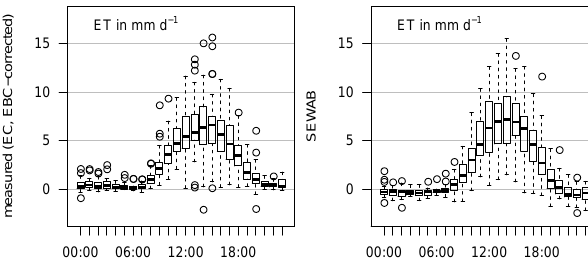
Figure B2. Mean diel course of measured and energy balance corrected evapotranspiration ET (left panel) and SEWAB modelled ET (tile approach according to the EC footprint: S RefEC , right panel) over 61 days during 2010 (3 June to 2 August) at Kema: box plot with median, 25% and 75% quartiles; bars represent quartiles ± 1.5 times interquartile range, dots are outliers. Measured and modelled values are restricted to high flux data quality (flag 1–3). Measured data is corrected according to the surface energy imbalance with the buoyancy flux correction.